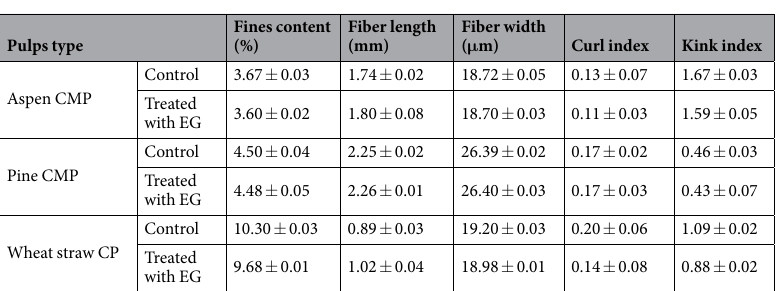
that: (1) high hemicellulose content in the softwood pulp affected the accessibility of enzyme 33, 34 ; (2) compared